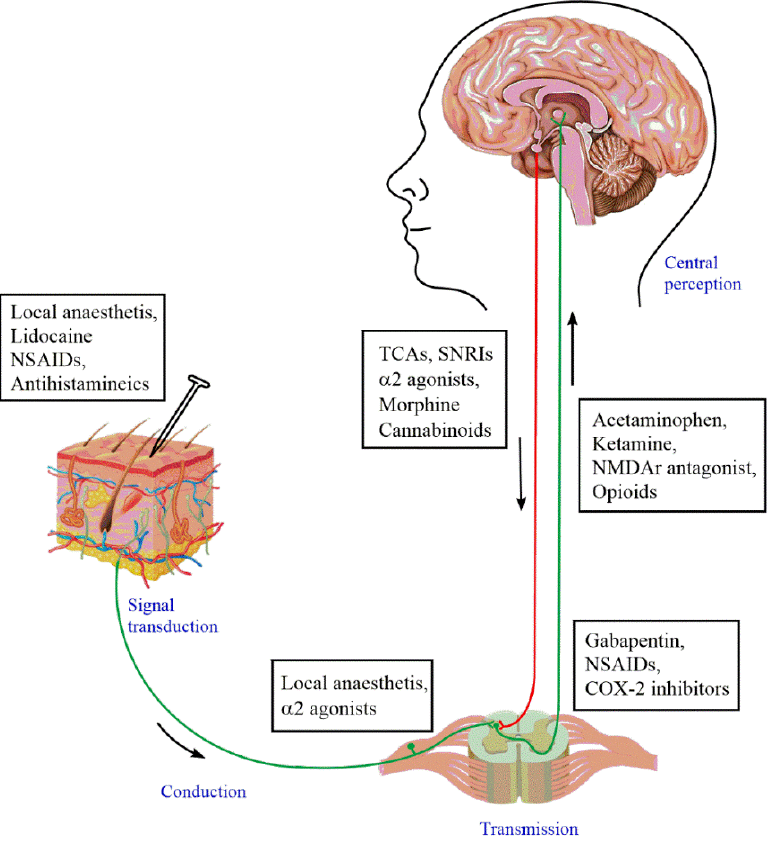
Figure 2. Pain pathway and pharmacological interventions. From tissue trauma to central sensitization, different analgesics are known to act at various points of pain transmission. At the site of injury, local anaesthetics, antihistamines, and anti-inflammatory agents can be used for direct pain relief. Opioids and non-opioid drugs including morphine, cannabinoids, COX-2 inhibitors, α 2 agonists, gabapentin, acetaminophen, and tricyclic anti-depressants (TCAs) act both peripherally as well as centrally, hence attenuating the transmission of pain signaling.